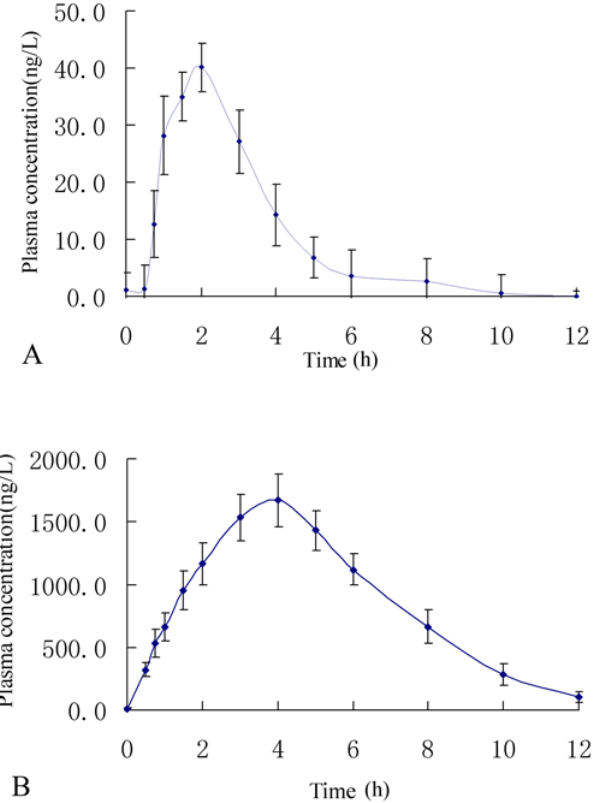
or subcutaneous injection of rhGM-CSF. A: Average hGM-CSF serum concentration versus time in 19 subjects after oral administration of BmrhGM-CSF (8 m g/kg). B: Average hGM-CSF serum concentration versus time in 19 subjects after subcutaneous injection of rhGM-